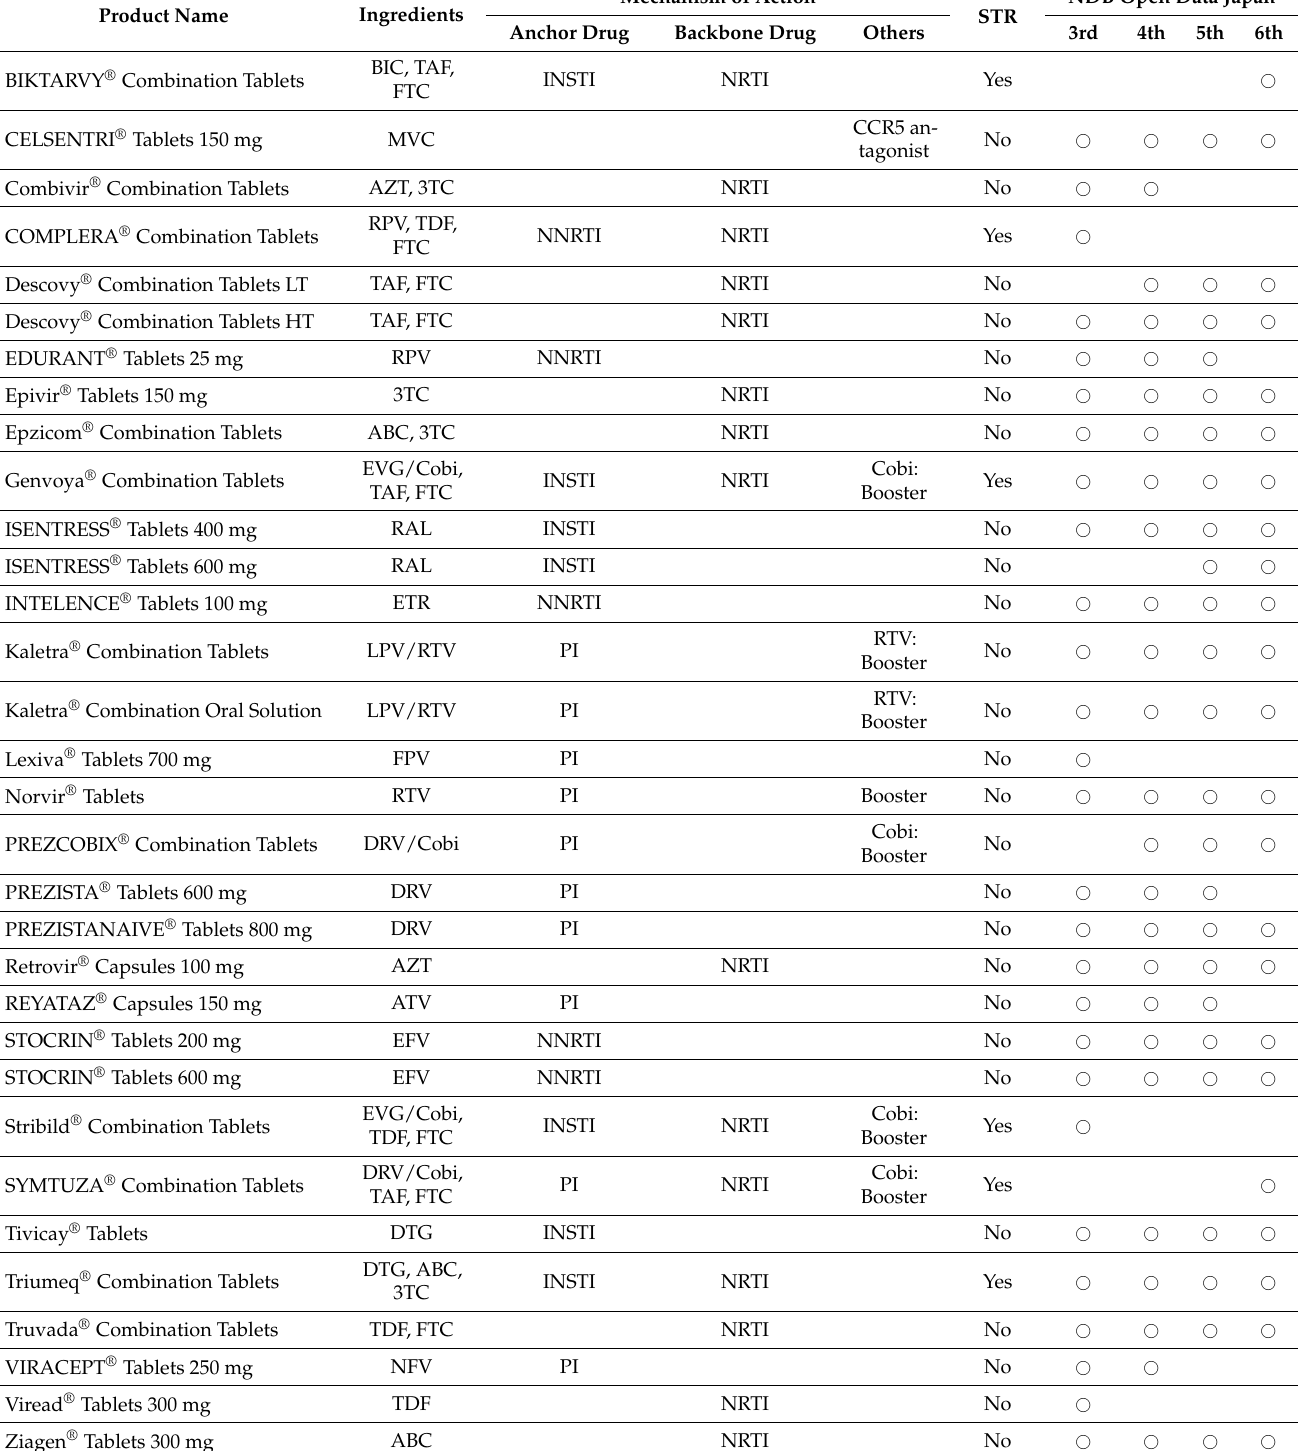
Table 1. The list of anti-HIV drugs included in the 3rd, 4th, 5th, and 6th NDB Open Data